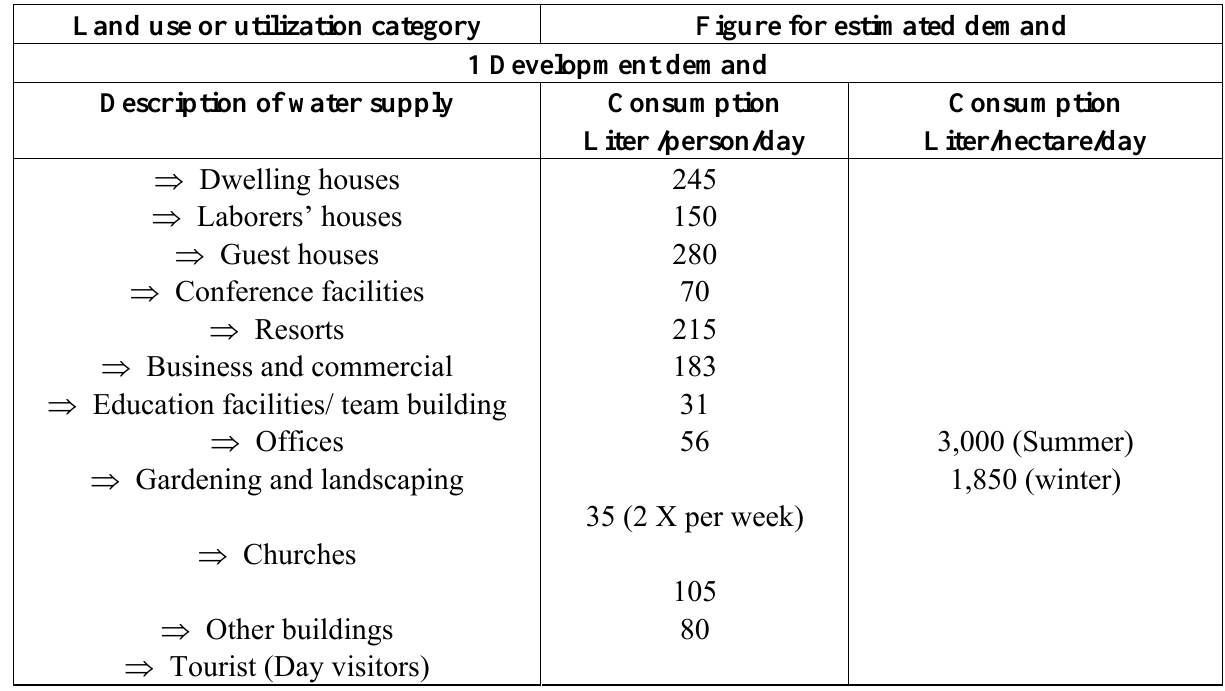
Table 7. VDWHS Water supply and demand